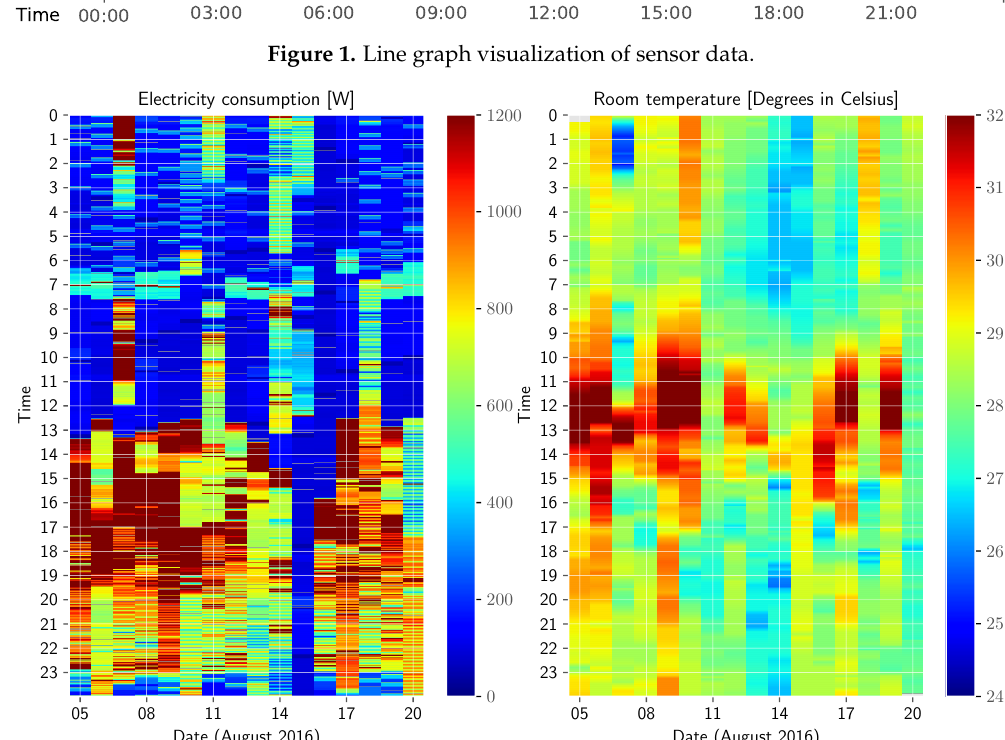
Figure 2. Heatmap visualization of sensor